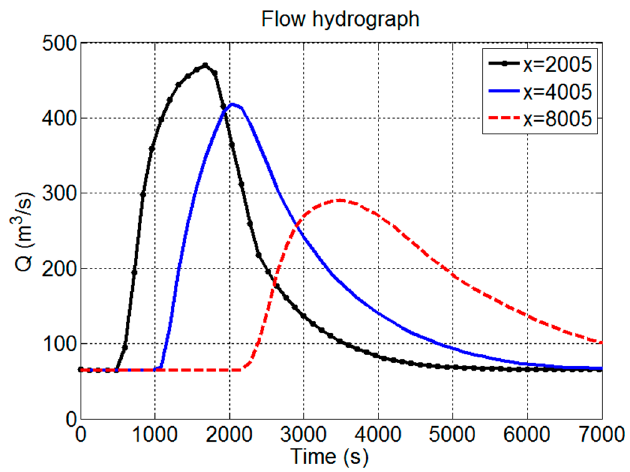
Figure 10. Wave attenuation hydrographs at different cross-sections x, along modelled channel.